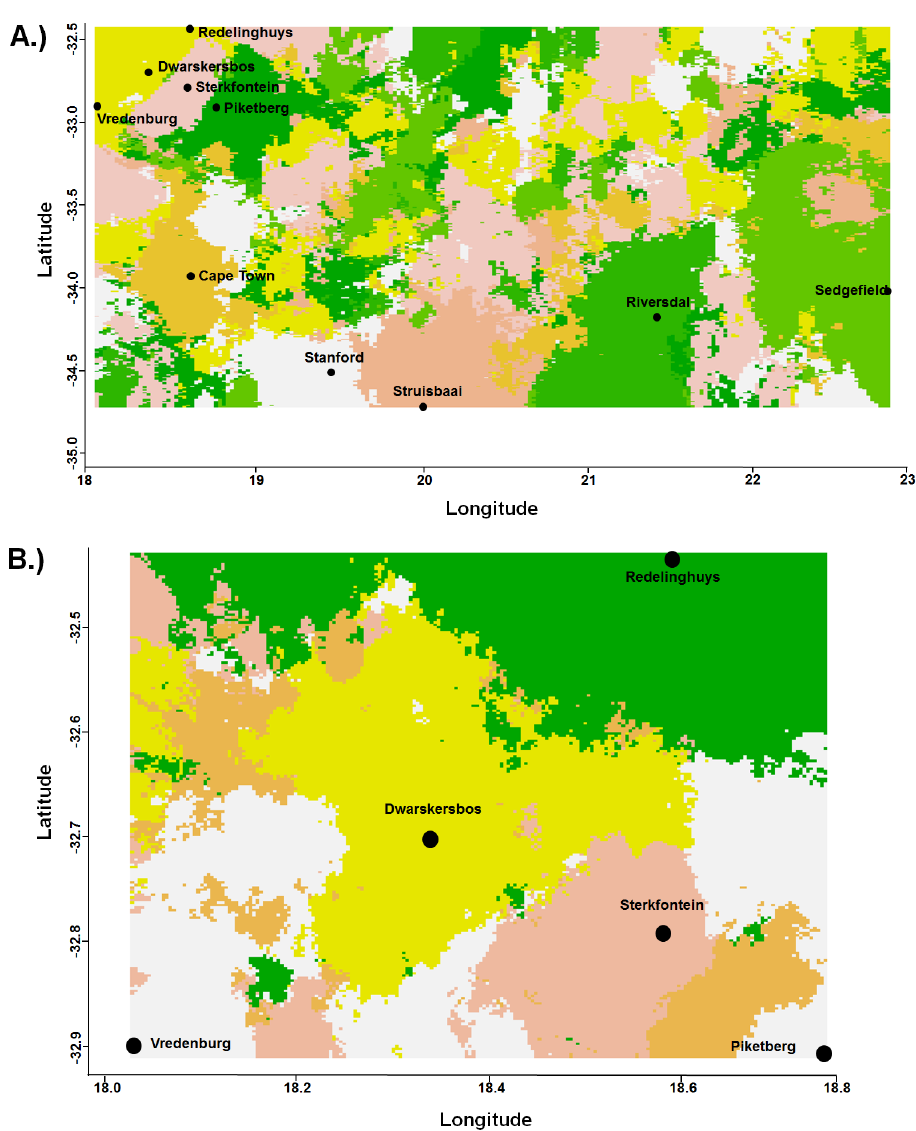
Figure 3. Genetic groupings revealed by the Geneland analysis at regional and local scales. Genetic groupings revealed by the Geneland analysis of the microsatellite data on a A) regional (Cape Floristic Region) and B) local (Sandveld) spatial scale. Dots reflect the location of each population and the colours correspond to each separate genetic grouping.